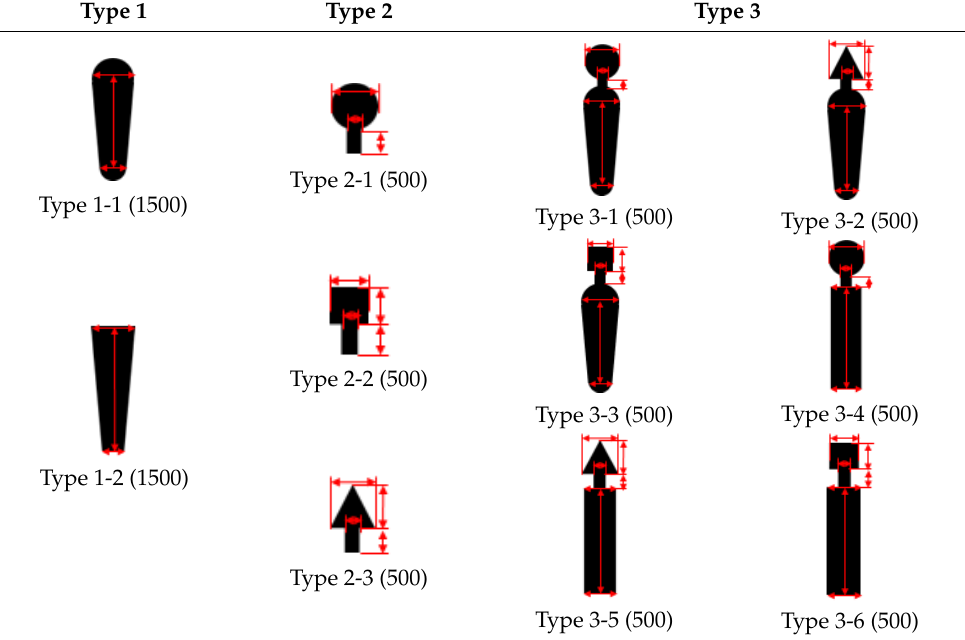
Table 3. Cases of the training data.